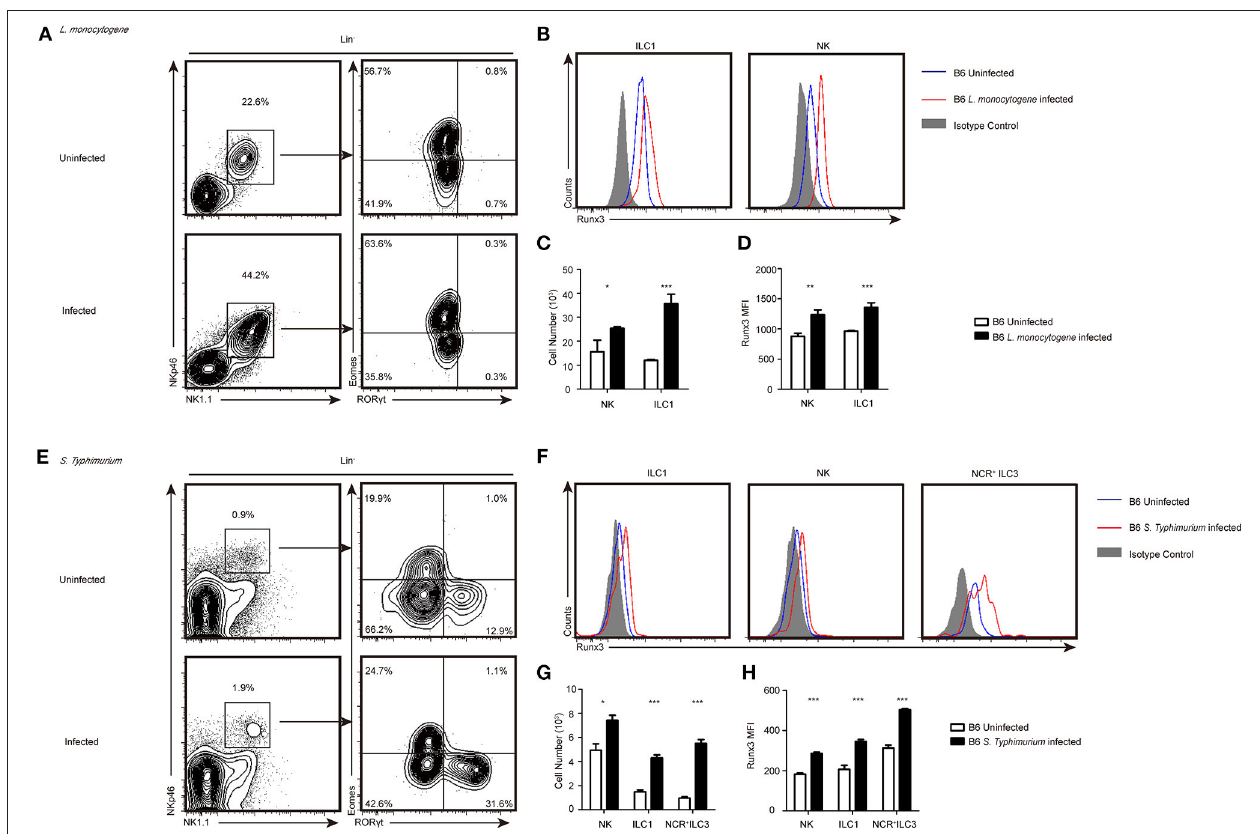
FIGURE 1 | Group 1 ILCs and NCR + ILC3s accumulated intracellularly in bacteria infected organs and upregulated the expression of Runx3. (A–D) B6 mice were infected with L. monocytogenes through tail vein injection as the infected group ( n = 3) or injected with sterile PBS as the uninfected group ( n = 3). (A) Flow cytometry assay of the percentage of ILC1s and NKs from the livers of both groups. ILC1s were stained Lin − NK1.1 + NKp46 + ROR γ t − Eomes − and NKs were Lin − NK1.1 + NKp46 + ROR γ t − Eomes + . (B) The expression of Runx3 was analyzed by flow cytometry in ILC1s and NKs from the liver. The isotype controls are the shaded curves, uninfected groups are blue curves and infected groups are red curves. (C) Absolute number of total ILC1s or NKs from livers before and after infection. (D) Flow cytometry analysing the expression of Runx3 in the indicated cell types. (E–H) B6 mice were infected with S. typhimurium by gavage administration as the infected group ( n = 3) or lavaged with sterile PBS as the uninfected group ( n = 3). The isotype controls are shaded curves, uninfected groups are blue curves and infected groups are red curves. (E) Flow cytometry assay of the percentage of ILC1s, NKs and NCR + ILC3s in both groups. NCR + ILC3s were stained Lin − NK1.1 + NKp46 + ROR γ t + Eomes − . (F) The expression of Runx3 was analyzed by flow cytometry in ILC1s, NKs and NCR + ILC3s from the intestine. (G) Absolute number of total ILC1s, NKs or NCR + ILC3s from the intestines before and after infection. (H) The expression of Runx3 in ILC1s, NKs and NCR + ILC3s from